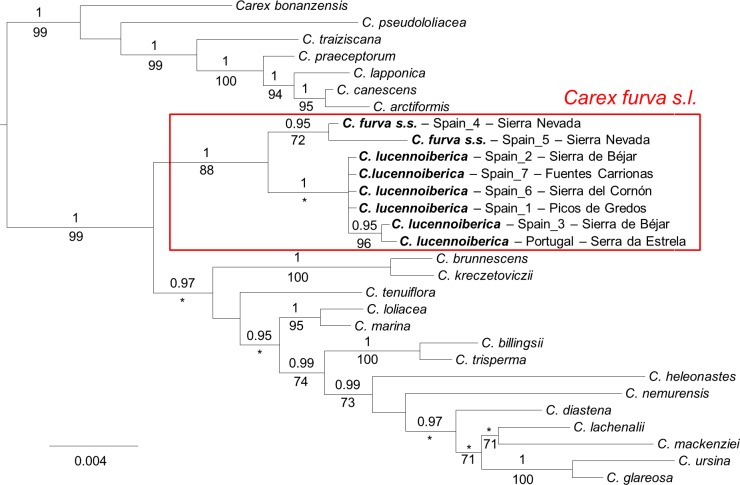
Majority-rule consensus tree from Bayesian inference analysis of the concatenated matrix of nrDNA regions ETS, ITS, G3PDH and cpDNA region matK.Posterior probabilities (PP, only if higher than 0.9) from the Bayesian analysis and bootstrap values (if > 70%) from the maximum likelihood analysis are shown above and below branches, respectively. Lack of support in only one analysis is represented by asterisks. Tip labels indicate species name. In the case of C. furva s.s. and C. lucennoiberica, we have also included sampling locality. Red square represents the boundaries of C. furva s.l. Scale bar indicates substitutions per site.